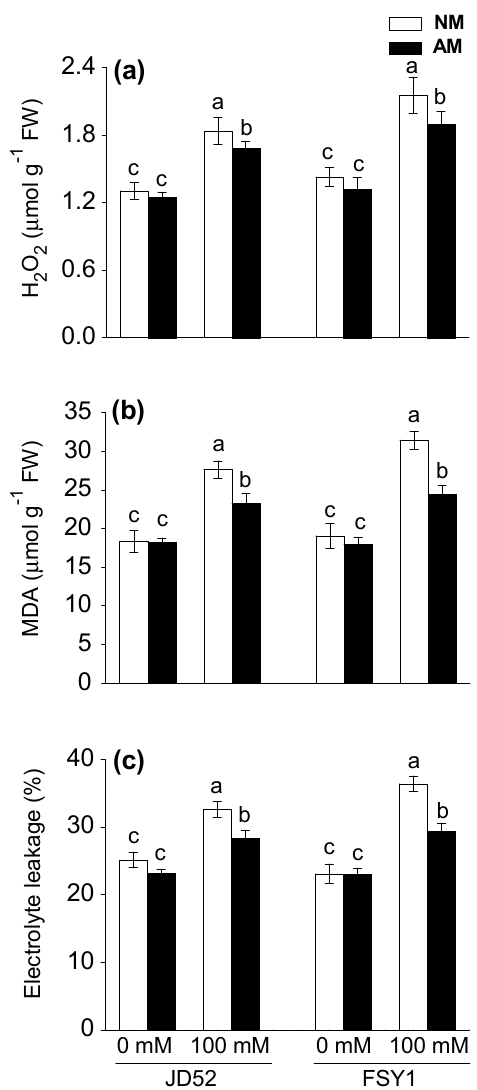
Figure 4. Hydrogen peroxide content ( a ), lipid peroxidation ( b ), and electrolyte leakage ( c ) in two maize genotypes (JD52 and FSY1) inoculated with Funneliformis mosseae (AM) or without inoculation (NM) in 0 and 100 mM NaCl treatments assessed at 59 DAS. For each trait, bars with different letters indicate significant differences ( p ≤ 0.05).